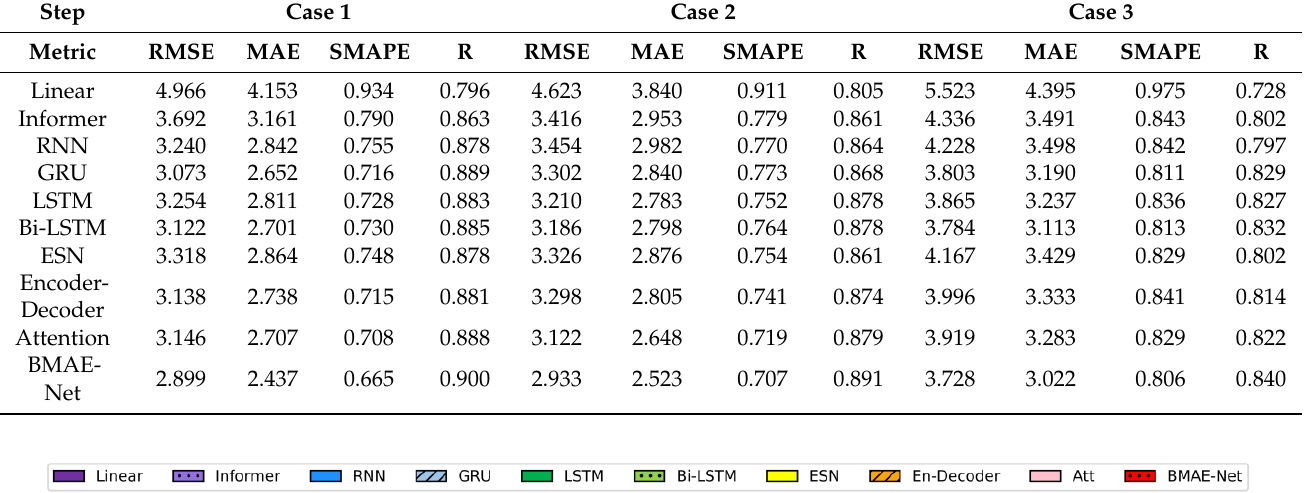
Table 3. Experimental results for temperature from the Shenyang station.